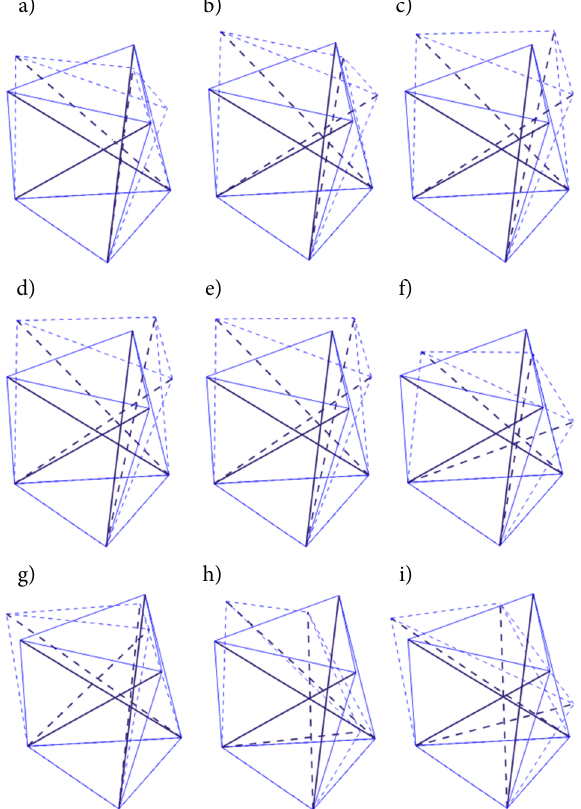
Fig.3. The nine mode shapes of the Tripod simplex